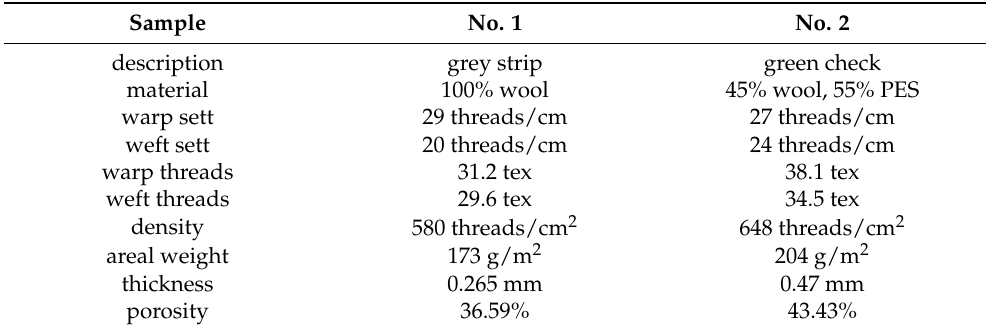
Table 1. Parameters of tested samples.